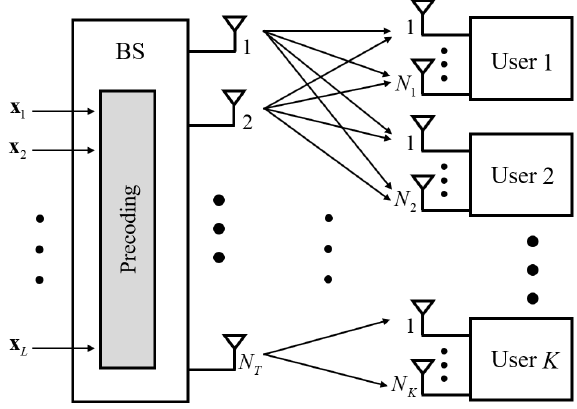
Figure 1. System model of the multi-user multiple input multiple output (MU-MIMO) downlink